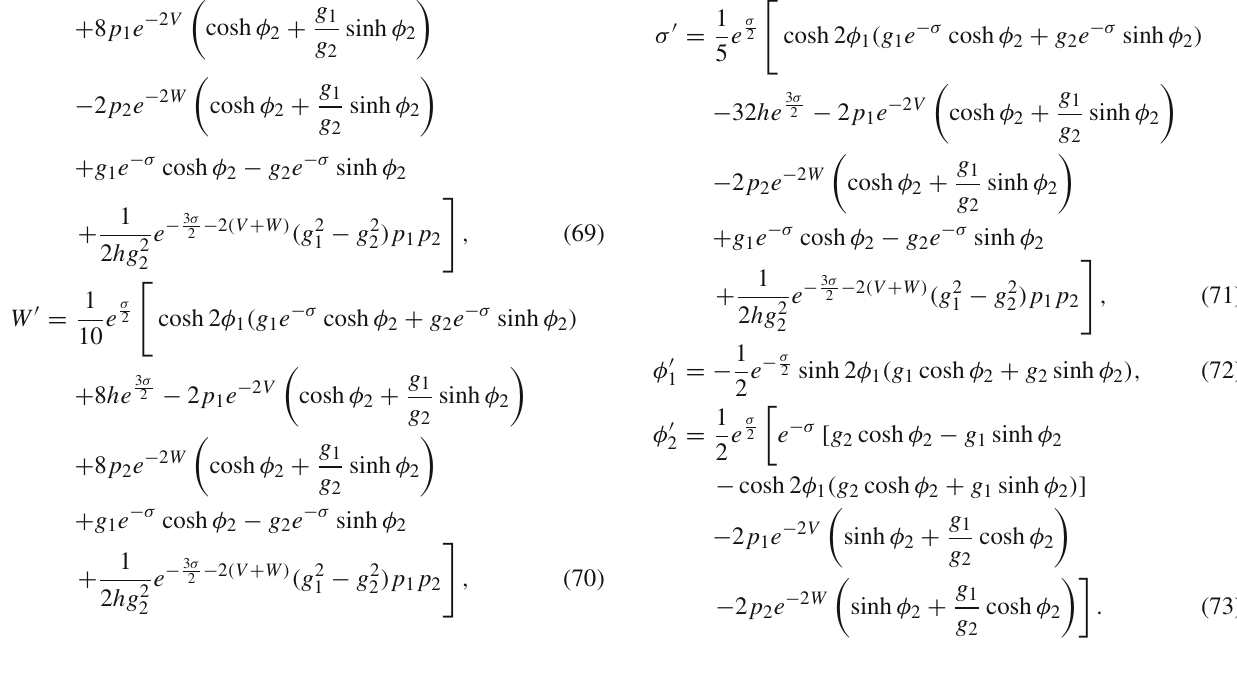
, − 2 ),( 1 , − 5 ),( 1 , − 2 ),( − 1 , 9 ) (blue, yellow, green, 14 9 6 3